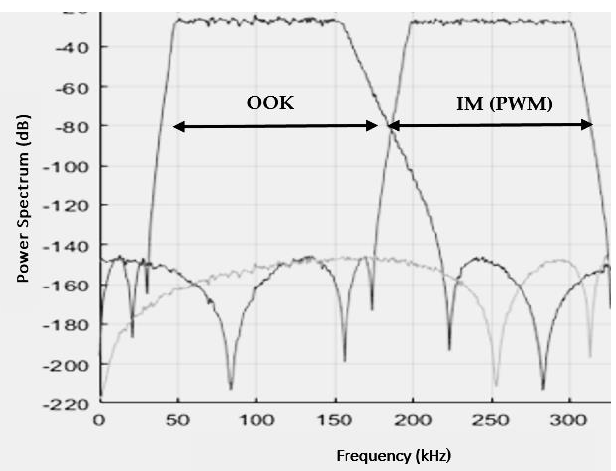
Figure 3. Mapping Algorithm Block Diagram.